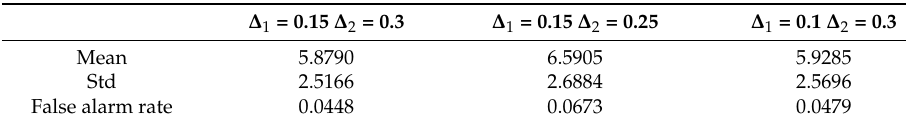
Table 4. The results for robust tests.